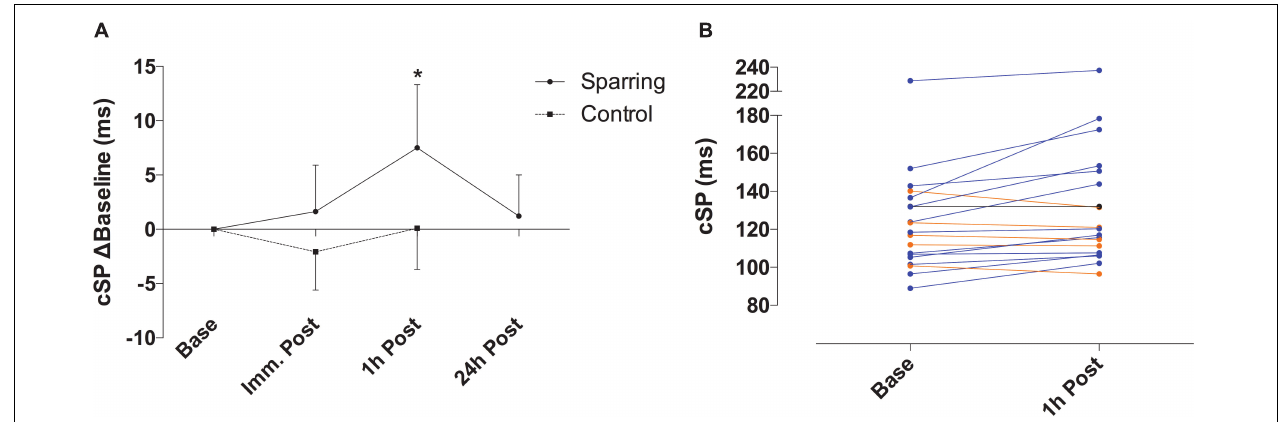
FIGURE 1 | (A) Difference of cSP for sparring and control groups, relative to baseline. Inhibition appeared increased following sparring, peaking at the 1 h mark with a 6% increase, and returning to pre-values by the 24 h follow up. ∗ p < 0.002 following sparring; error bars indicate 95% CI. (B) Change in cSP duration for each participant from baseline to 1 h following